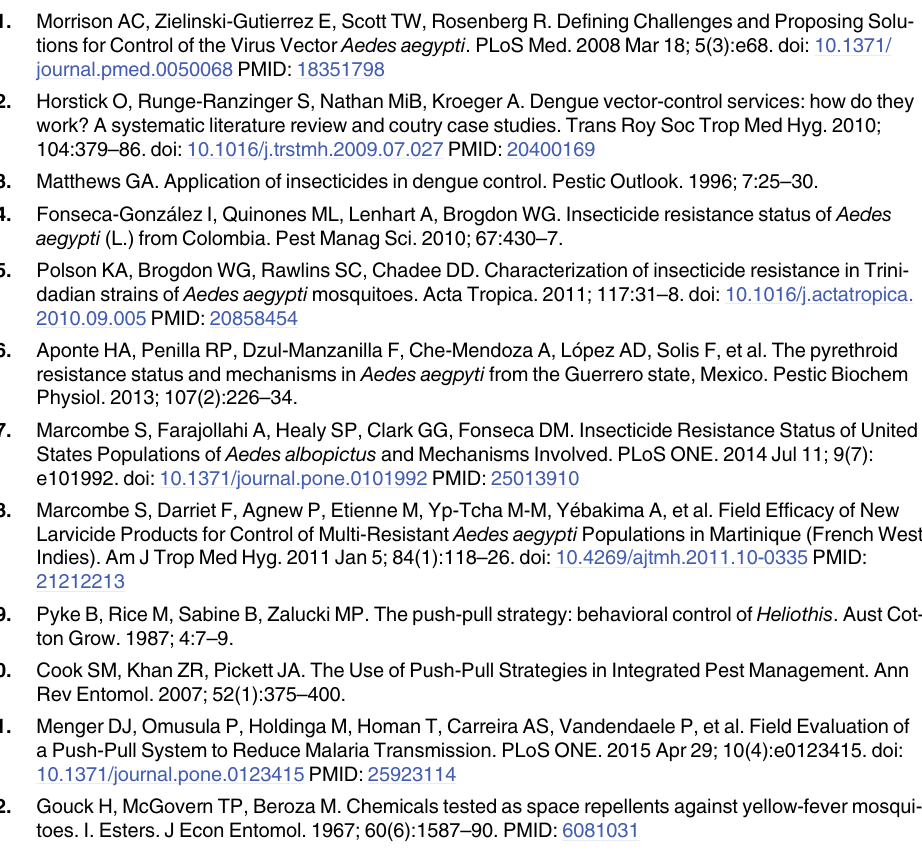
S4 Fig. Sketch of the air curtain generated by the FFS. Air volume was estimated at 0.24 m 3